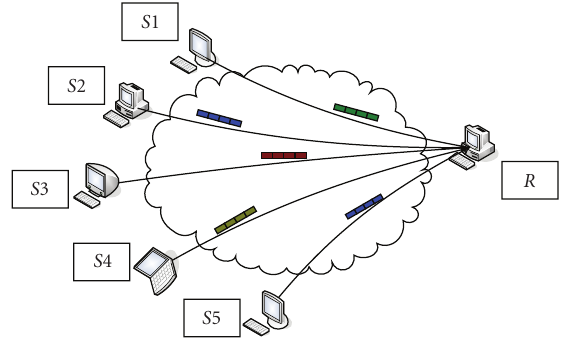
Figure 1: Proposed